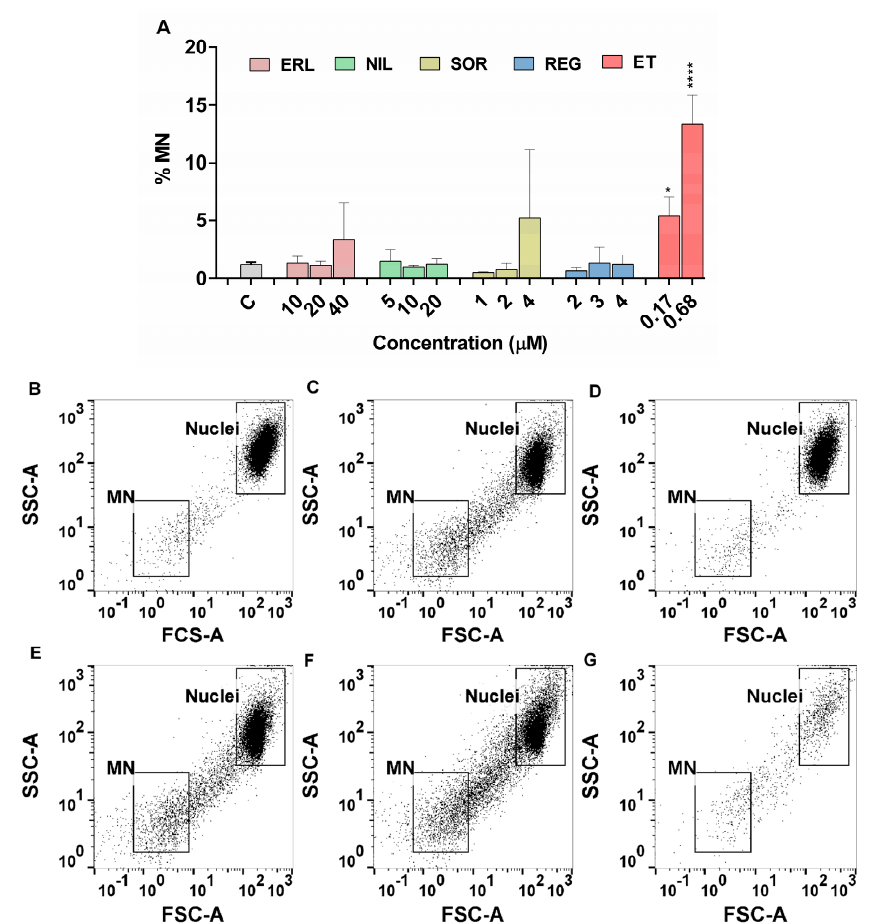
Figure 5. Induction of MN in ZFL cells after 72 h exposure to TKIs as determined by flow cytometry ( A ). A total of 20,000 nuclei were counted per each experimental point. Nuclei and MN were stained with Sytox Green, and dead cells were excluded from analysis using EMA (ethidium monoazide) stain. Three independent experiments were performed. ET (0.17 and 0.68 μ M) was used as positive control. * ( p < 0.05), **** ( p < 0.0001). ( B – G ) Representative dot plots of ZFL nuclei and other subcellular particles as analyzed by flow cytometry. Dot plots show the distribution of nuclei (main nuclei population in upper right corner) and micronuclei particles (in lower left corner) within the